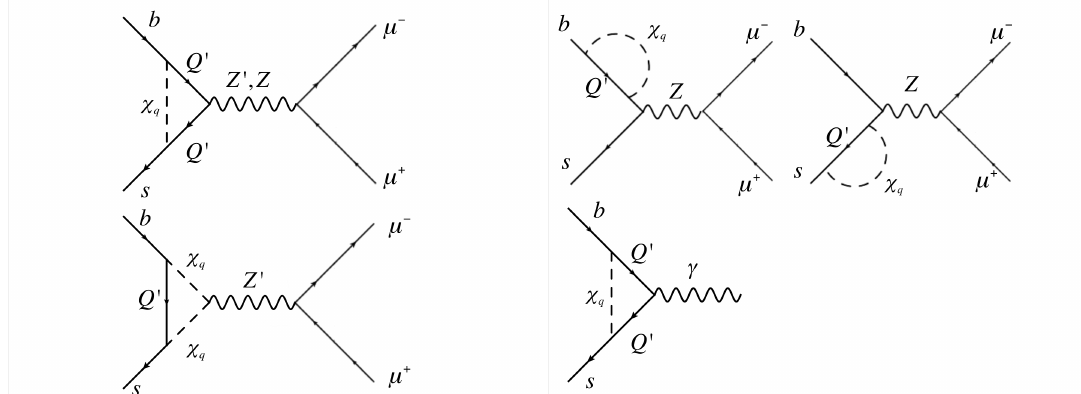
( Z µ )¯ bγ µ P L s + h.c. and µ